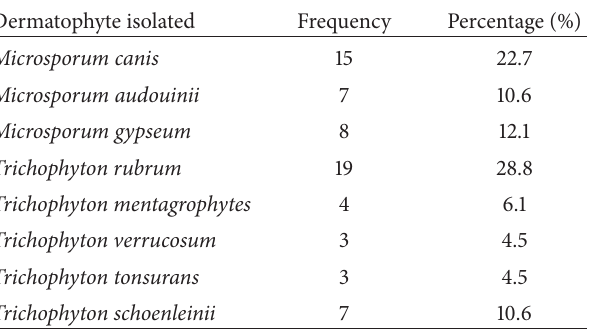
Table 2: Frequency of isolated dermatophytes from school children in Nok community, Kaduna